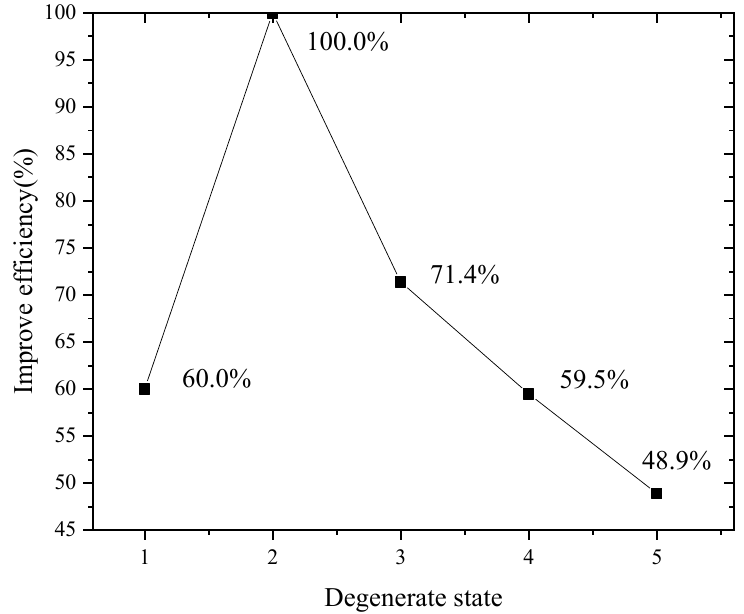
Figure 15. Improve efficiency by increasing the number of points.